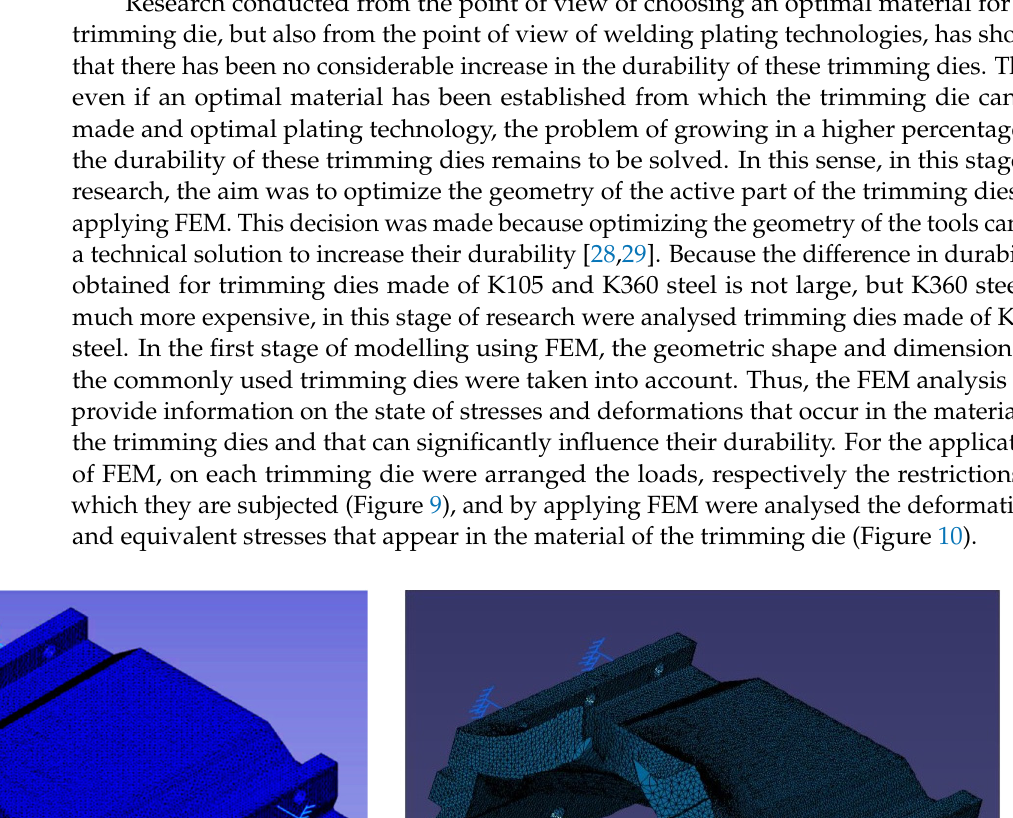
Figure 8. The metallographic structure of the transition area between the metal deposited by welding and the base material: ( a )—the metallographic structure in case of cold plating welding of